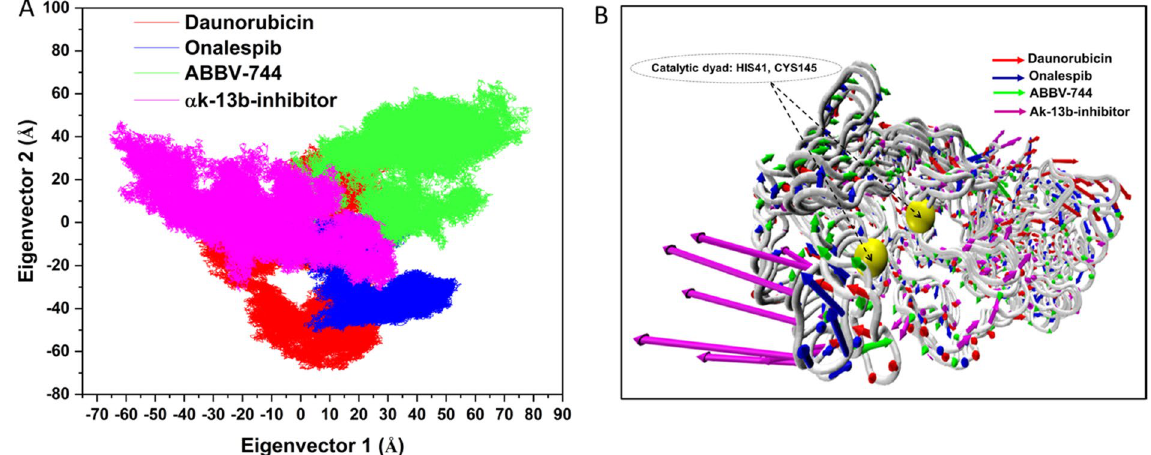
Figure 7. ( A ) PCA plot constructed by eigenvector 1 vs eigenvector 2 for Daunorubicin (red), Onalespib (blue), ABBV-744 (green) and αk-13b inhibitor (magenta) complexes. ( B ) PC1 collective motions for the obtained predominant eigenvectors using principal component analysis over the 200 ns MD trajectories for Daunorubicin-M pro , Onalespib-M pro , ABBV-744-M pro and αk-13b inhibitor-M pro .